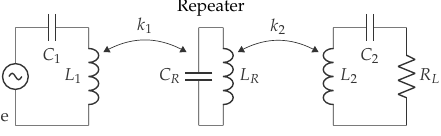
Figure 25. Example of magnetic resonance coupling with LC repeater. The equivalent series resistances for the coils L 1 , L R , and L 2 are R L Adequate capacitors C 1 , C R , and C 2 ensure that all circuits operate in resonance (51). k 1 and k 2 represents the coupling factors between L 1 and L R and between L R and L 2